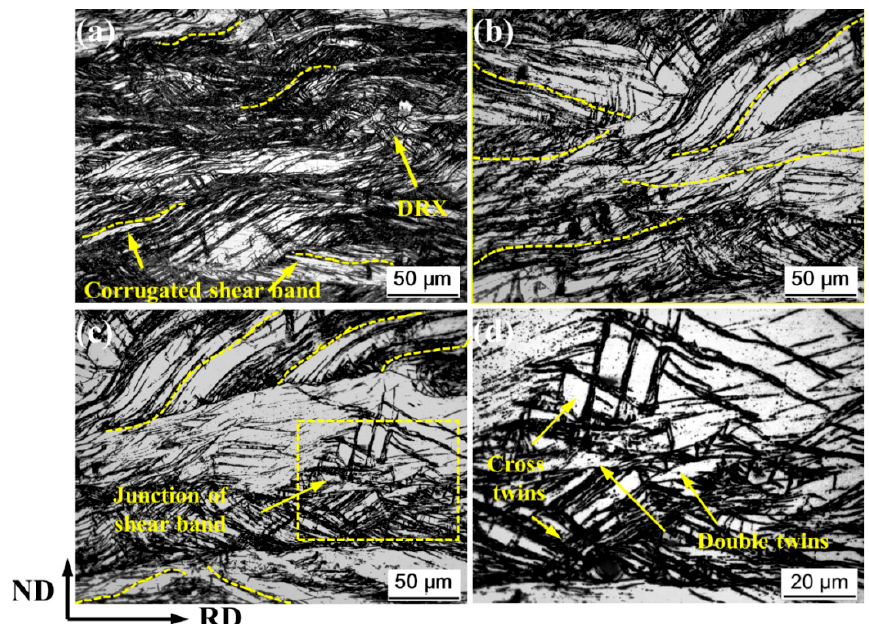
Figure 4. Detailed metallographic microstructure of RR50%: ( a , b ) shear band, ( c ) junction of shear band, and ( d ) twins.